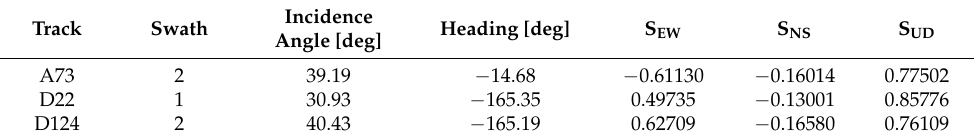
Table 5. Values of sensitivity parameters for conversion of GNSS to satellite LOS.